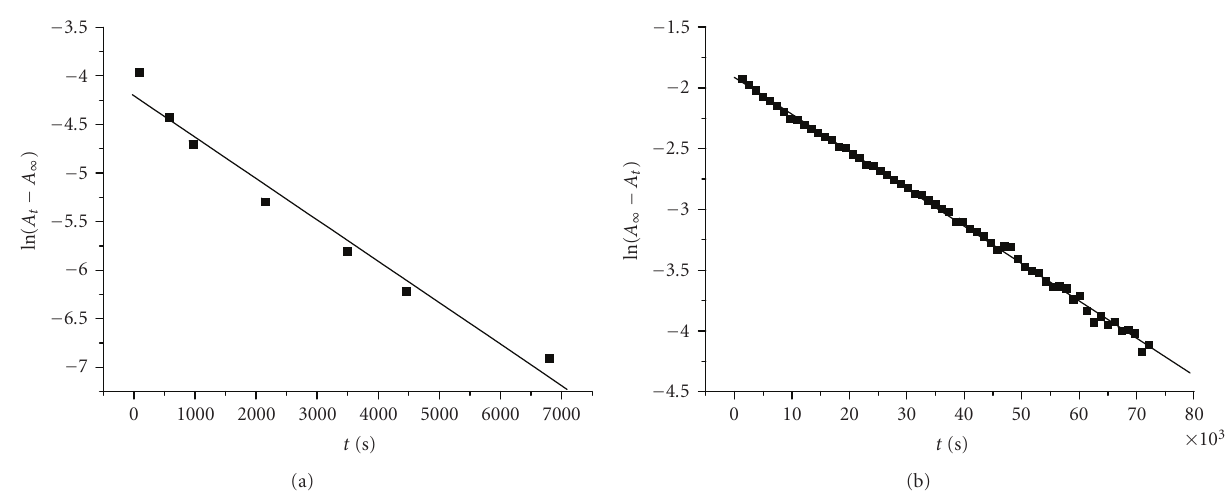
Figure 2: Plots of ln( A t − A ∞ ) (first stage) and ln( A ∞ − A t ) (second stage) versus time (a) [2,4-DHBA] = 2,92 · 10 − 2 M, [Cr(III)] = 2,50 · 10 − 3 M,